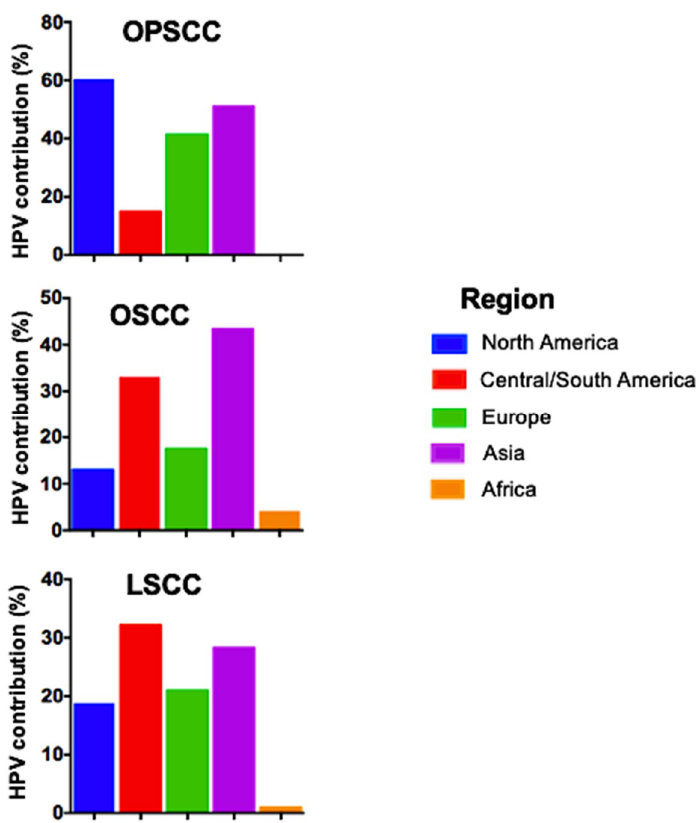
Figure 4. Distribution of human papillomavirus-associated head and neck cancers (HPV + HNC) between geographical regions. Percent HPV + HNC cases in North America, Central/South America, Europe, Asia, and Africa.